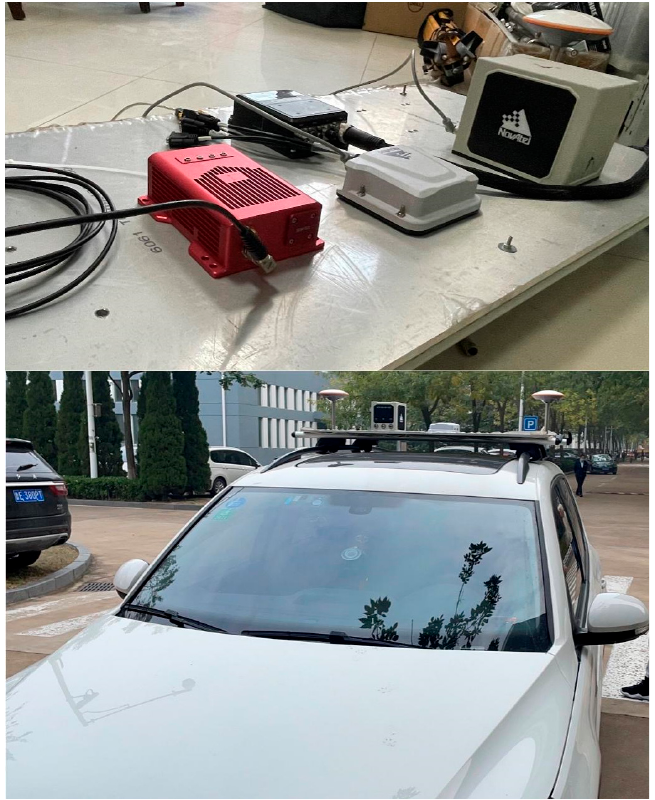
Figure 1. Experimental equipment mounted on the